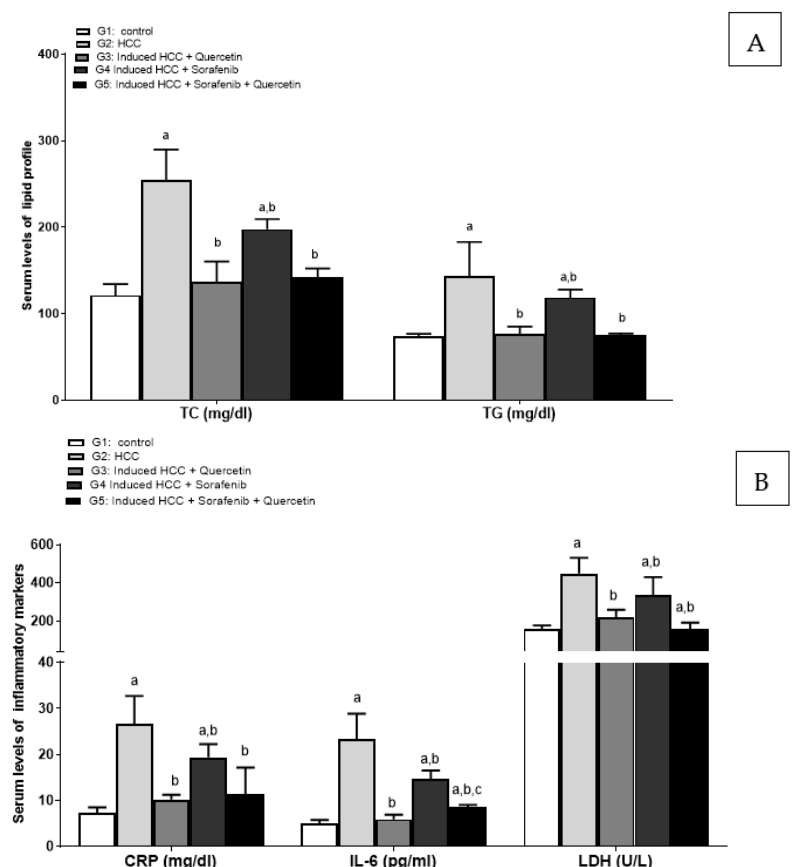
Figure 4. Serum levels of lipid profile (TC and TG) ( A ) and inflammatory markers CRP, IL-6 and LDH ( B ). Data were expressed as mean +/ − standard deviation. Significance was made using one-way ANOVA test followed by least significant test. a: significance versus group 1. b: significance versus group 2. c: significance versus group 4. TC: total cholesterol; TG: total triglyceride; CRP: C- reactive protein; IL-6: Interleukin -6; LDH: Lactate dehydrogenase. Significance at p <